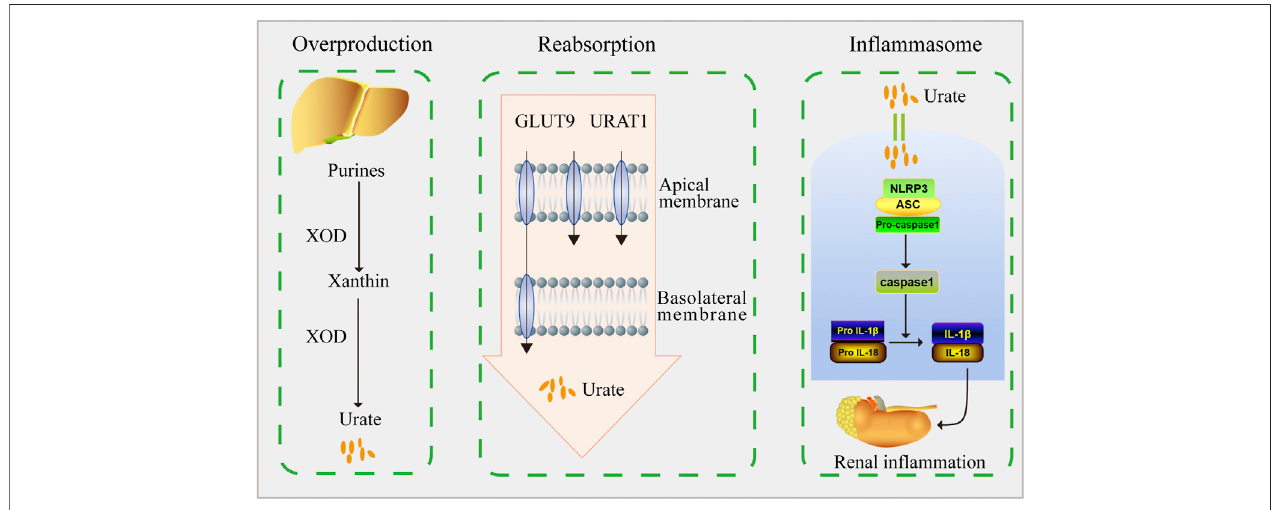
FIGURE 8 | Schematic diagram of this study. DHB exhibited dual anti-hyperuricemic effects via inhibiting hepatic XOD activity as well as down-regulating renal URAT1 and GLUT9 expression. Moreover, DHB possessed renoprotective effect by inhibiting NLRP3 in fl ammasome activation.